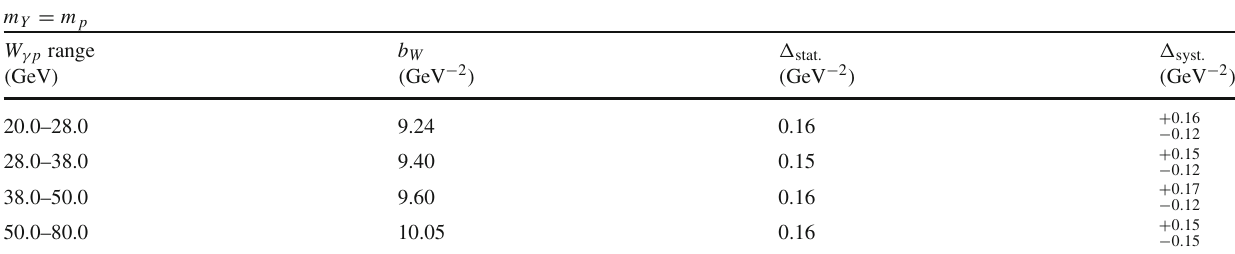
Table 15 Fit parameters b W for the fit of t dependencies of the elastic differential ρ 0 photoproduction cross sections d σ(γ p → ρ 0 p )/ d t in bins of W γ p (cf. Table 12). The statistical and full systematic uncer-